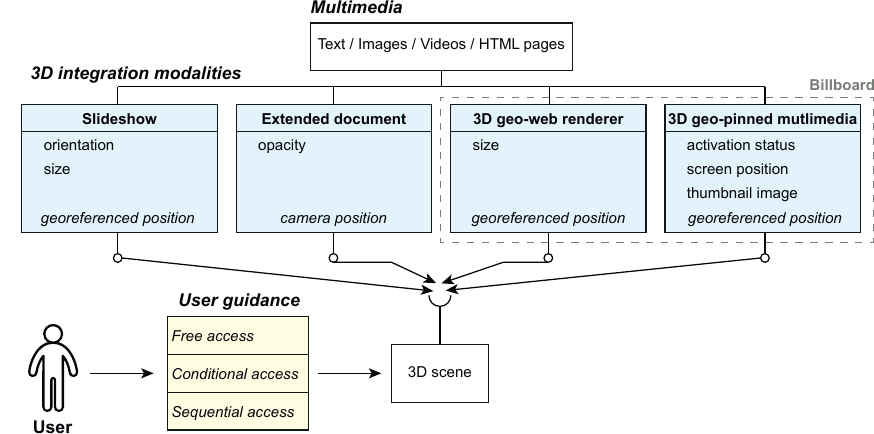
Figure 1. Architecture diagram of our proposed model. The multimedia can be integrated in the 3D scene using one of the multimedia integration approaches (in blue). Each approach is characterized by attributes that allow to parameterize the integration. The media are linked to the scene by either a georeferenced position or a camera position (shown in italic). The user can consume the integrated media in the scene through different guidance modes (in yellow).